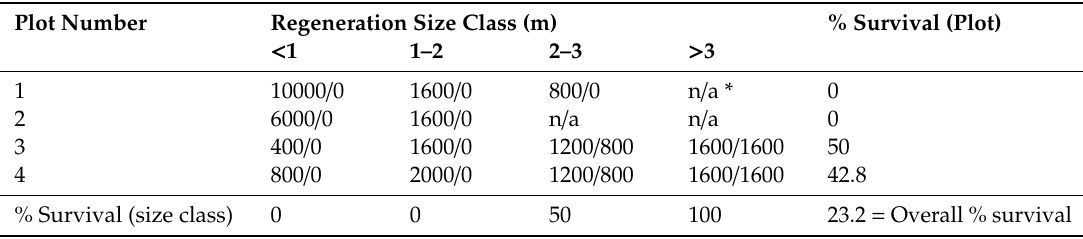
Table 3. Advance regeneration (pre-burn / 10-month post-burn) per hectare following prescribed fire in a slash pine